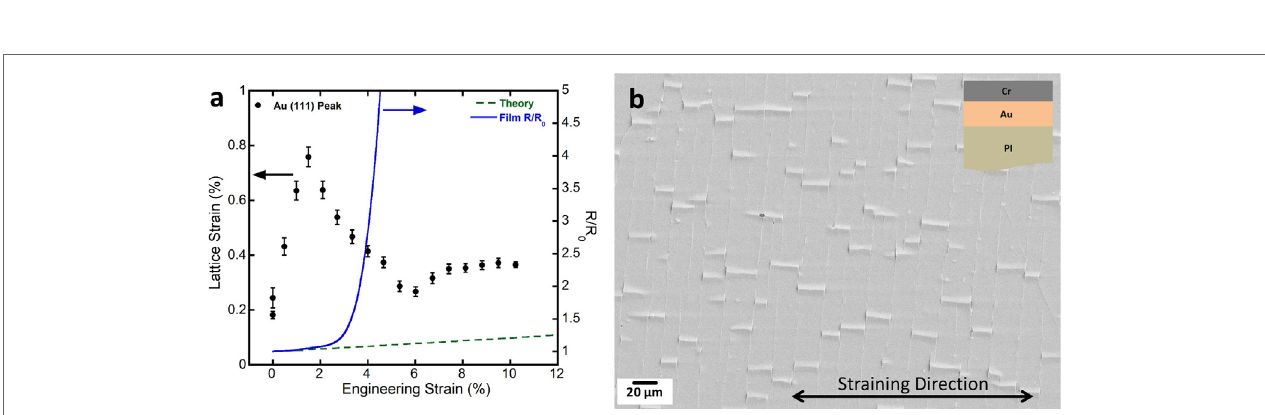
FigUre 4 | (a) In situ XRD and 4PP results of the 300-nm Au film with a 200-nm Cr overlayer on PI illustrating brittle film electro-mechanical behavior. (B) SEM micrograph after straining to 11% illustrating that cracks formed through both the Cr and Au films along with